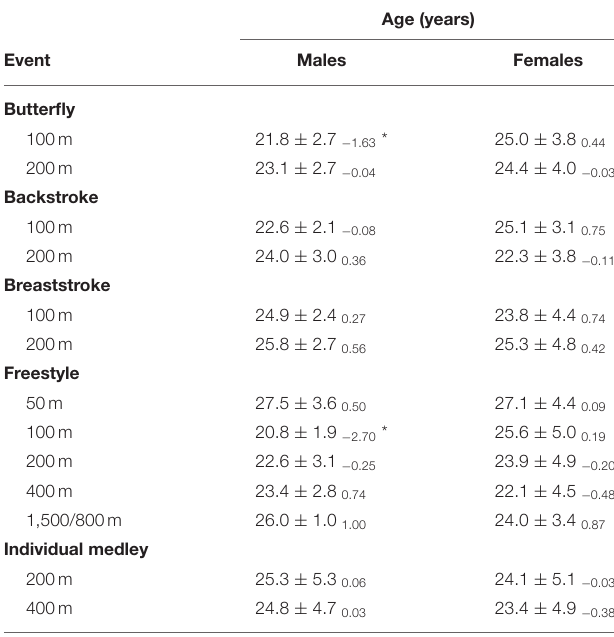
TABLE 1 | Age (mean ± standard deviation) of the 2021 European championship finalists, with a significant difference (*) to the 2016